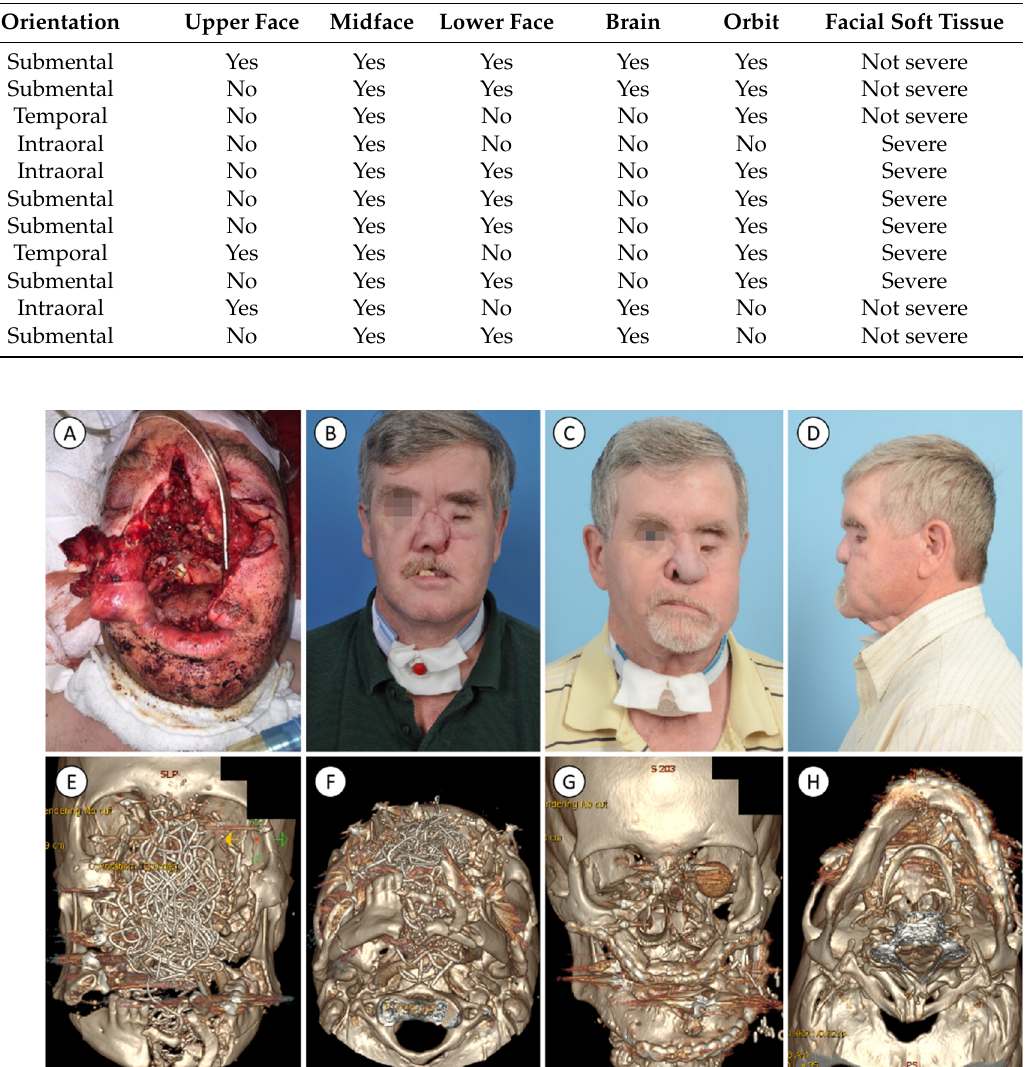
Figure 2. ( A ) 62-year old male with self-inflicted gunshot wound to the face resulting in massive comminuted midface and mandible fractures. AP and lateral photos ( B ) prior to and ( C , D ) after complex mandible, midface, and nasal reconstruction. 3D CT scan of the same patient ( E , F ) pre- and ( G , H ) postreconstruction. Table 1. Patient characteristics (N = 22). Patients averaged 5.4 reconstructive surgeries (range: 1 to 26), although some patients moved away or were lost to follow-up. Nine patients (40.9%) had 5 or more procedures, and three (13.6%) had 10 or more. Five patients (22.7%) ultimately received at least one regional flap, while seven (31.8%) received at least one free flap. Seven (31.8%) of these were free fibulas: four for mandibular and three for maxillary reconstruction. There were 11 regional and 11 free flaps performed in total, including 2 radial forearm flaps, 1 anterolateral thigh flap, and 1 serratus anterior flap. The average time to initiating secondary reconstruction with a free or regional flap was 179 days (range: 9 to 676), although four of the seven patients began within 60